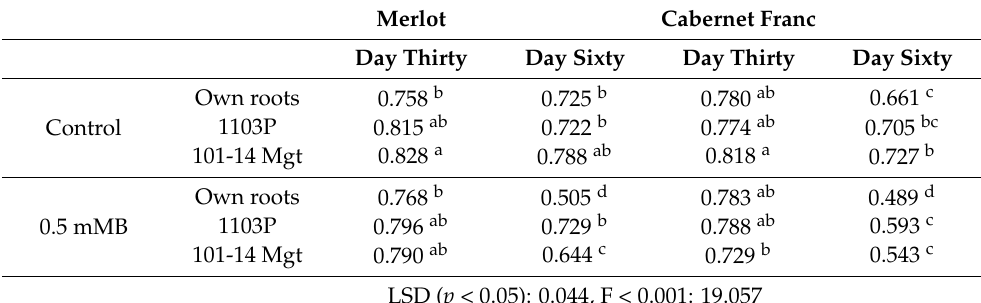
Table 6. Effects of boron toxicity on the maximum quantum yield of photosystem II (F v /F m ) in own- rooted Merlot and Cabernet Franc grapevine cultivar or grafted onto 1103P and 101-14 Mgt rootstocks. Merlot Cabernet Franc Day Thirty Day Sixty Day Thirty Day Sixty Own roots 0.758 Control